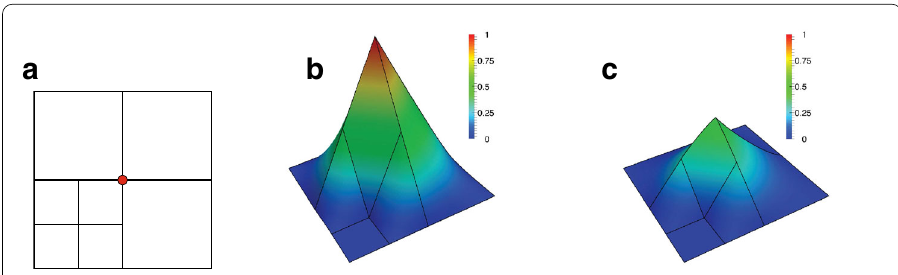
Fig. 9 h -adaptive mesh refinement and shape functions associated with the central node on the domain [0 , 1] 2 for the standard and enriched element. a Mesh. b Bilinear. c Bilinear enriched with exp( −| x | )